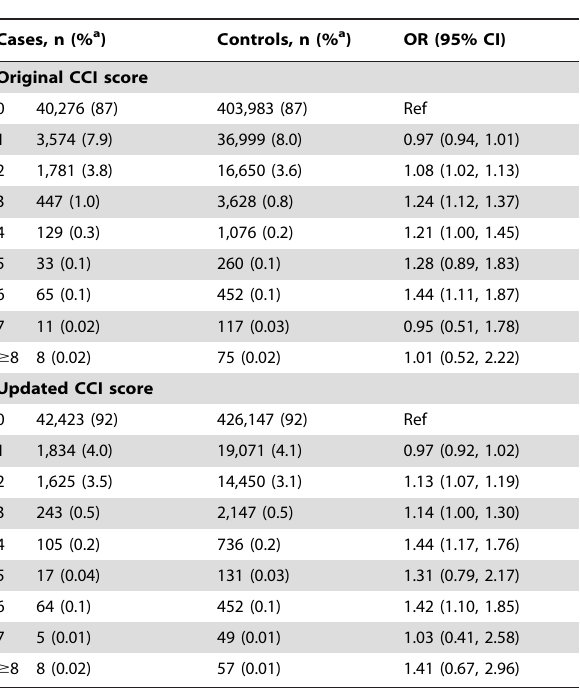
Abbreviations. OR: Odds ratio. a Because of rounding percentages may not add to 100.